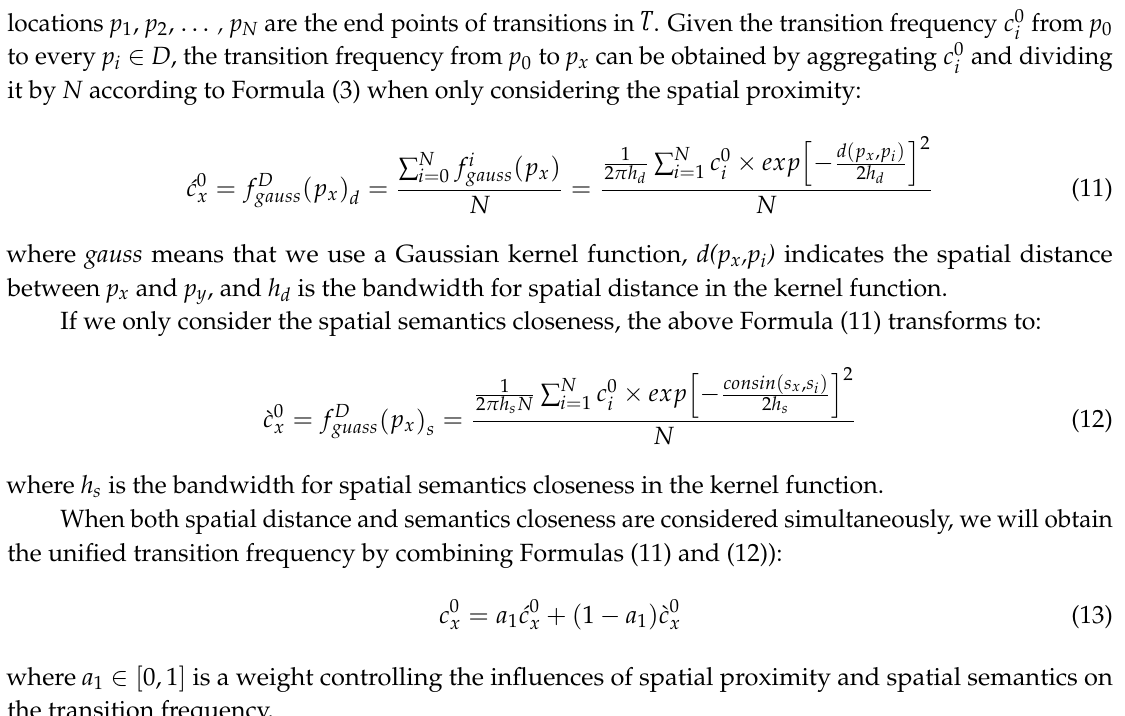
Figure 4. ( a ) trajectory location to peripheral location ( b ) peripheral location to trajectory location.